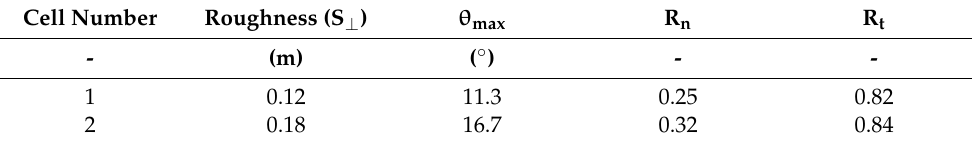
Table 3. Damping coefficients and artificial roughnesses used for the Rifle rockfall test site. The obtain matching results with CRSP 4.